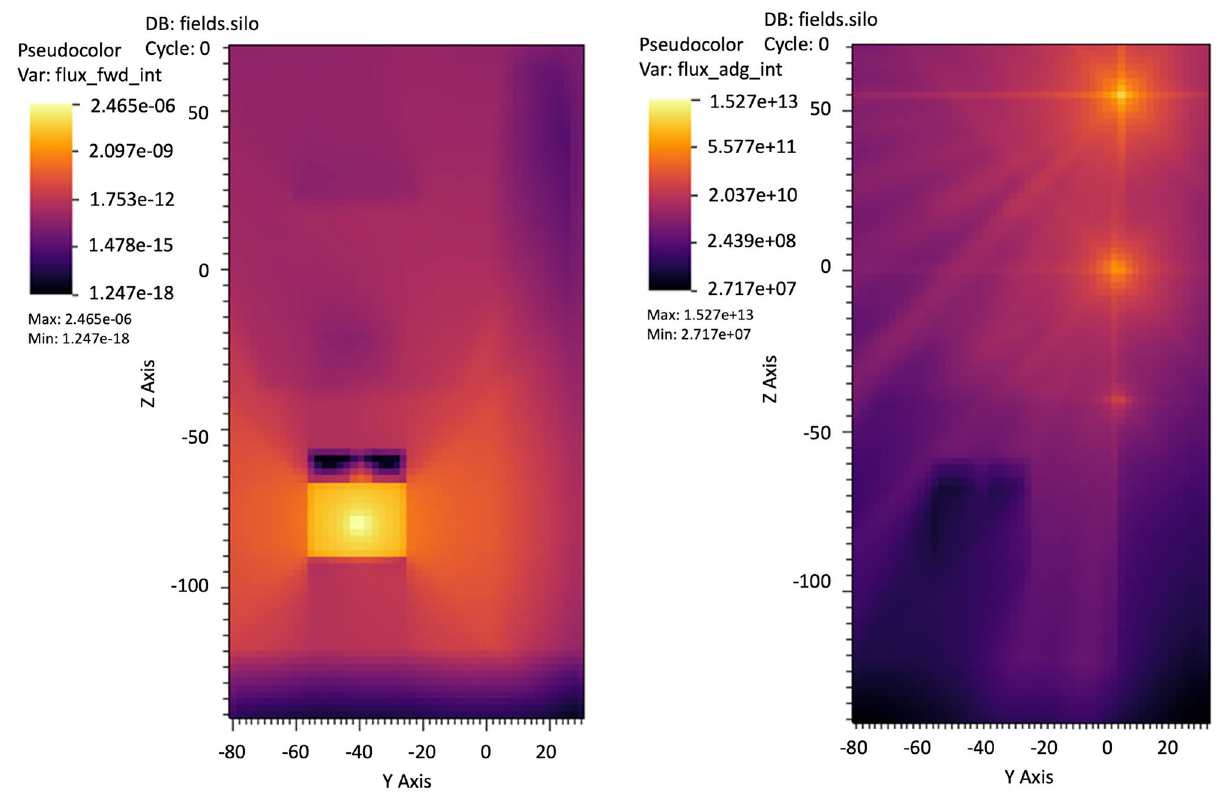
Figure 3. Typical Weight Window generation chain for MCNP, calculated with the ADVANTG discrete ordinates code. Left, forward flux values map interpreted by ADVANTG from the MCNP input file used as basis or the WW creation. Right, adjoint flux reflecting the importance function of the problem. ADVANTG simulations on a rectangular mesh of 5.0E+ 05 elements, Legendre polynomial order for scattering anisotropy modeling equal to 3, 8azimuthal and polar angles per octant, DPLUS MG photon library 24 . See Fig. 2a–c for geometry